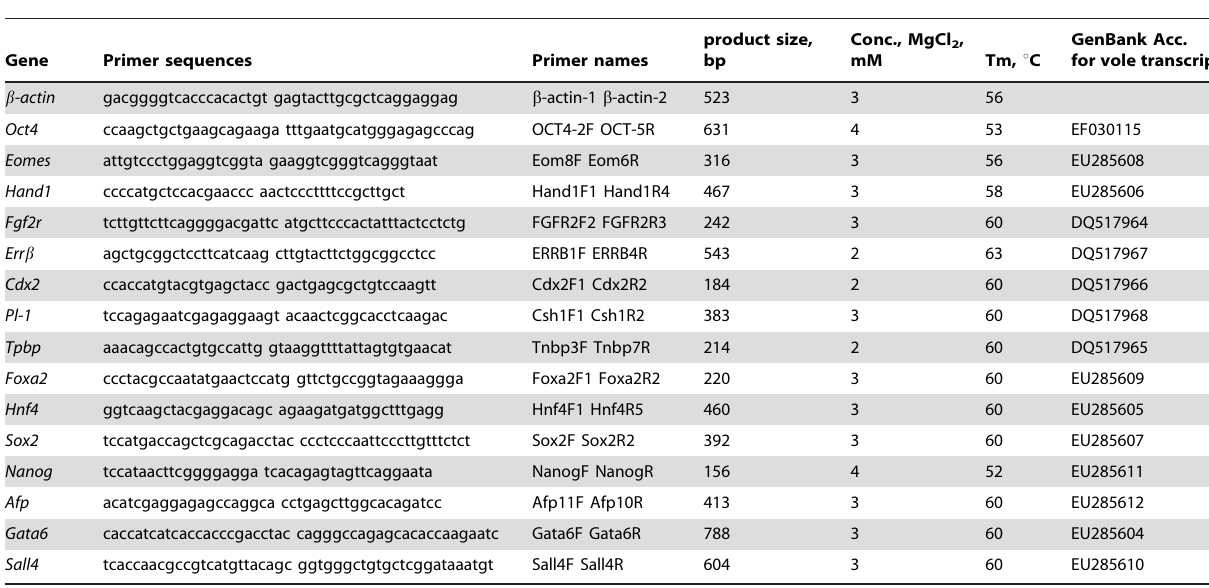
Table 2. Primers and PCR conditions for vole lineage-specific